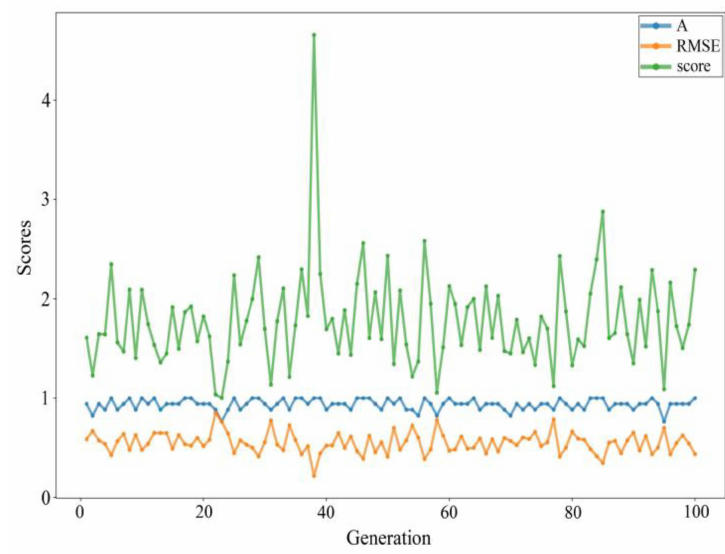
Figure 9. Cross-validation of evaluation